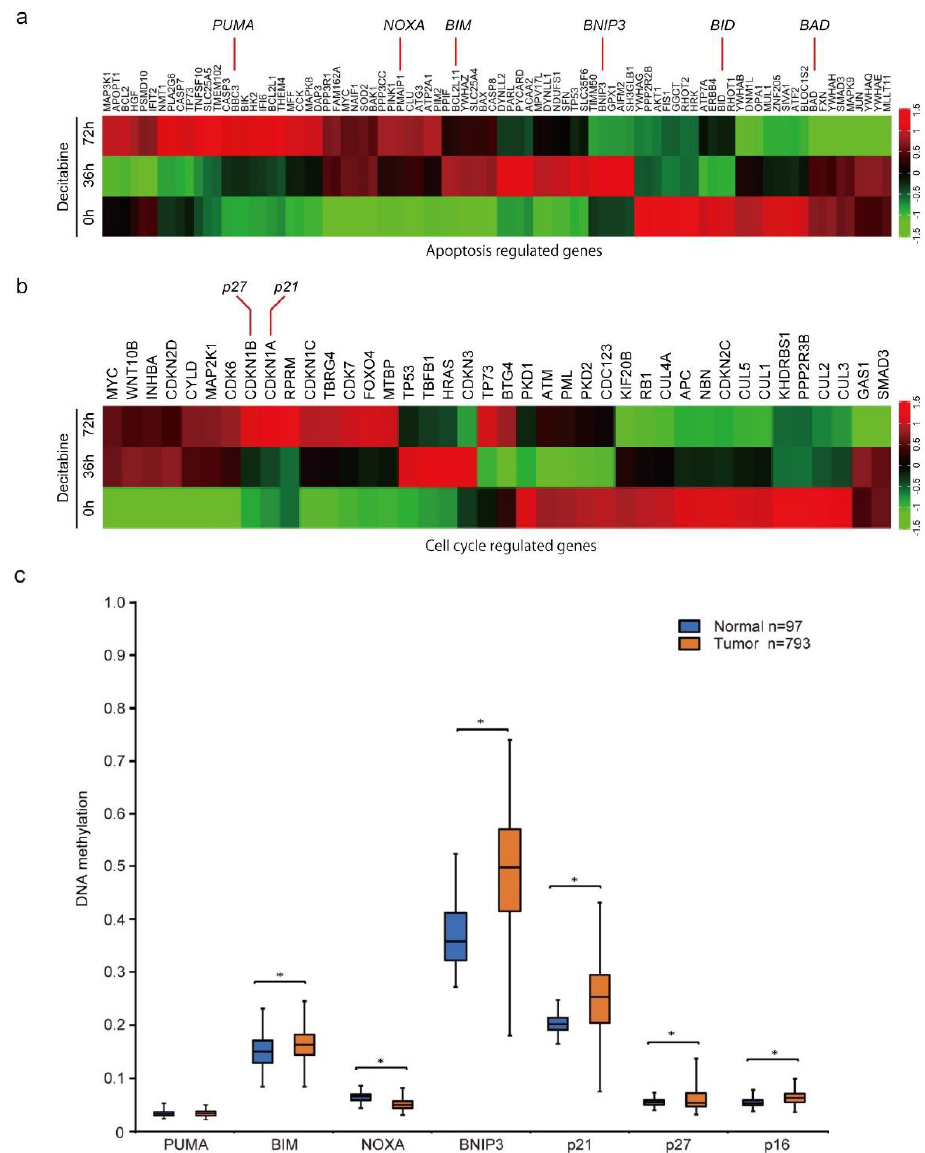
Figure 2. Differential gene expression and DNA methylation in mitochondrial apoptosis and cell cycle arrest genes in response to decitabine treatment. ( a , b ) RNA-seq expression analysis of HCC38 cells treated with vehicle or decitabine (500 nM) for 72 h. Heatmap of genes involved in ( a ) mitochondrial apoptosis and ( b ) cell cycle arrest. ( c ) The methylation level of each gene was examined by analyzing patient data extracted from The Cancer Genome Atlas database. *, p < 0.05. Having shown that decitabine induces apoptosis, we next analyzed the mRNA levels of BH3-only proteins in D-type cells by qPCR. In MDA-MB-468 cells, BIM , BNIP3 , and NOXA mRNAs were induced by decitabine (Figure 3a). In contrast, NOXA was induced but lower levels of BIM , BNIP3 , BIK , and PUMA mRNA were observed in HCC38 cells (Figure 3b). NOXA mRNA was analyzed in other cell lines, and the induction was only observed in G-type MDA-MB-157 cells (Figure 3c). We then analyzed NOXA and BIM protein levels in these cells. As shown in Figure 3d, NOXA and BIM proteins were induced in both G-type cells. In all cells, the levels of BCL-XL and MCL1 were not significantly affected by decitabine (Figure 3d). The role and mechanism of high NOXA levels in MDA- MB-231 cells was not further elucidated. However, NOXA is overexpressed in some can- cer cells [52], indicating the existence of an inactivation system of the proapoptotic func- tion of NOXA in these cells. In contrast to NOXA, BIM levels were constitutively observed and not markedly enhanced by decitabine (Figure 3d). In addition, decitabine-induced NOXA mRNA expression was observed in MDA-MB-157 cells (Figure 3c), but no NOXA protein expression (Figure 3d) and apoptosis induction (Figure 1b,e) was observed, sug- gesting that induction of apoptosis by NOXA is also regulated by post-transcriptional mechanism such as translation and stability of NOXA protein. These results indicate that NOXA plays a role in decitabine-induced apoptosis.